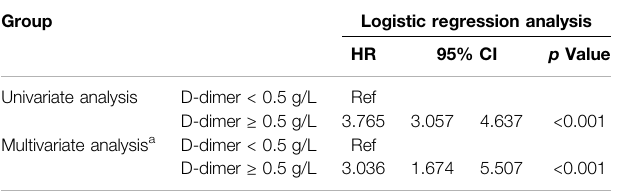
TABLE 5 | The risk of elevated D-Dimer for the disease severity of